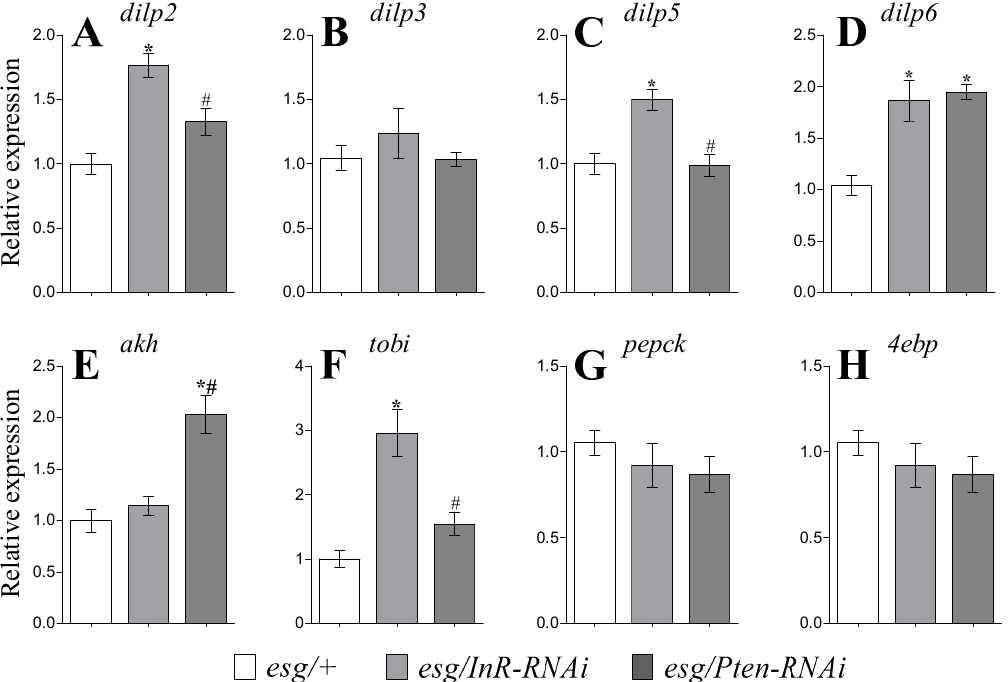
Figure 4. The mRNA levels for dilp2 ( A ), dilp3 ( B ), and dilp5 ( C ) in fly heads and dilp6 ( D ) from whole fly bodies and transcript levels of genes related to glucagon-like signaling and metabolism: akh ( E ), tobi ( F ), pepck ( G ), and 4ebp ( H ) from whole fly bodies. Parameters were measured in flies kept at 29 °C for six days for RNAi expression induction. Data are mean values for 4 independent measurements (± SEM). Group comparisons were performed using ANOVA followed by Newman–Keuls post hoc test. Asterisks indicate significant difference from the control flies ( esg/+ ) ( p < 0.05); hash signs show significant difference from flies with inhibited IIS ( esg/InR-RNAi ).